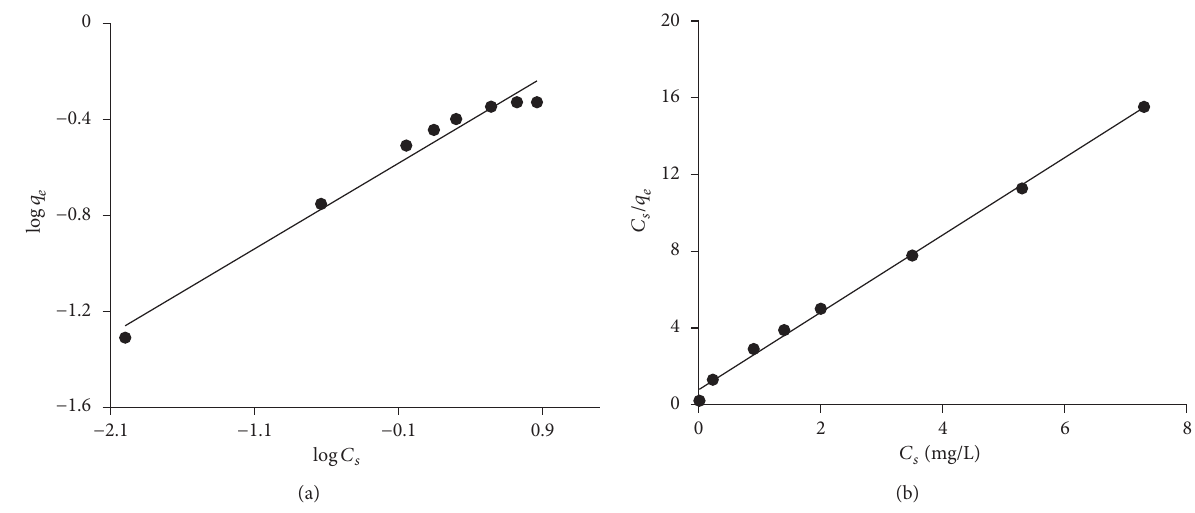
F 7: e Freundlich and Langmuir isotherms for �uoride adsorption using activated charcoal at